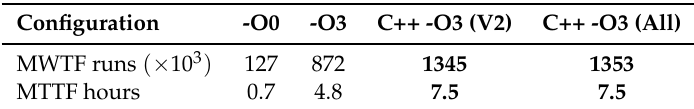
Table 8. Total MWTF and MTTF for different configurations. Highlighted values are those referenced in the text for the sake of